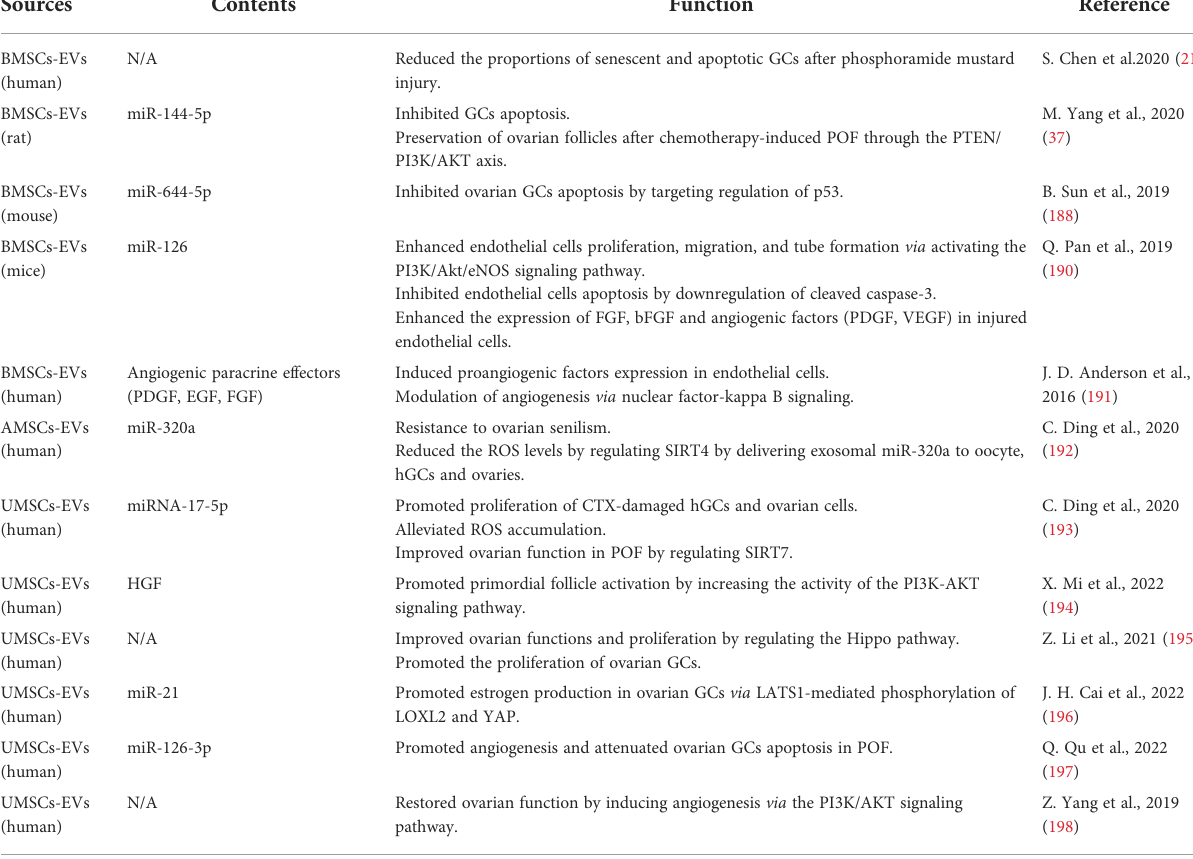
TABLE 4 Therapeutic effect of exosomes derived from MSCs in